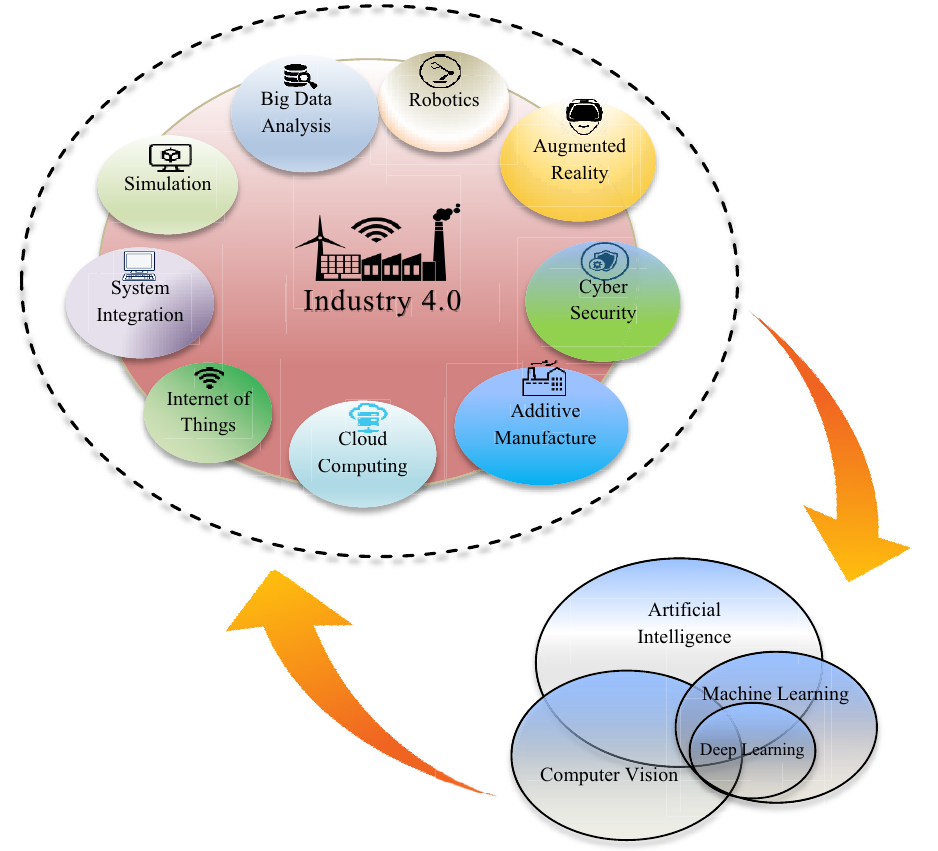
Figure 3: The relationship of the nine pillars of the industrial revolution 4.0 with AI, ML, deep learning, and computer